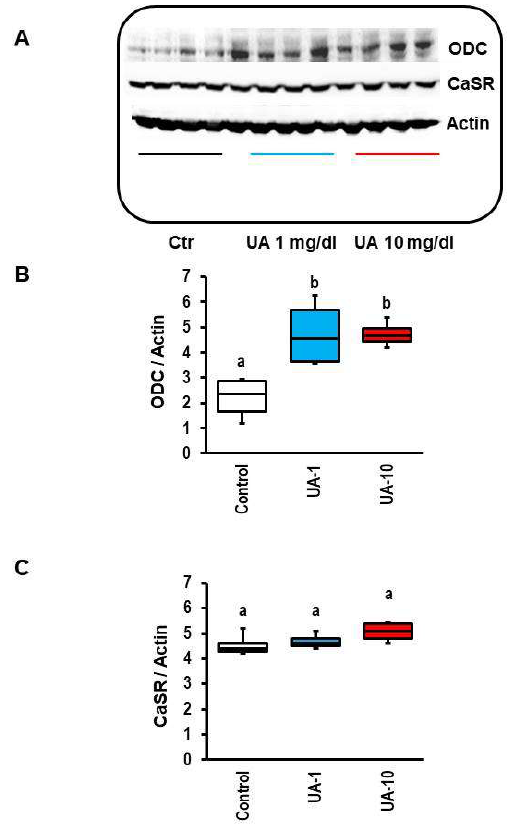
Figure 2. Effect of 24 h uric acid (UA) exposure on ornithine decarboxylase (ODC) and calcium-sensing-receptor (CaSR) expression. ( A ) Representative Western blot indicating the expression of ODC, CaSR, and Actin, which was used for normalization. ( B , C ) Quantitative analysis of ODC and CaSR expression, respectively. Data are expressed as bars and whiskers with median, 25% quartile, 75% quartile indicated by bars, and complete range by whiskers. Statistical analysis is based on one- way ANOVA and Student – Newman – Keuls post hoc analysis. a, p < 0.05 vs. control. Each n = 4 as